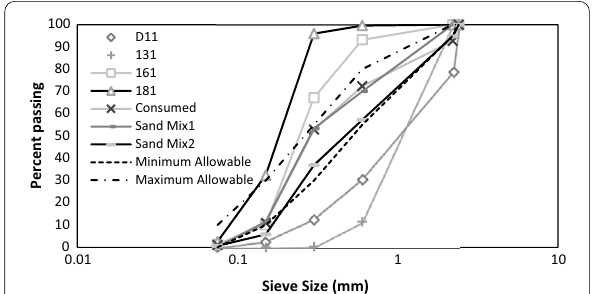
Fig. 2 Particle size distribution of Firuzkuh sand (ACI304.1-R-92, 1997; http:// tamin maseh. ir/ Conte nt/ Conte nt. aspx? PageC ode mode =